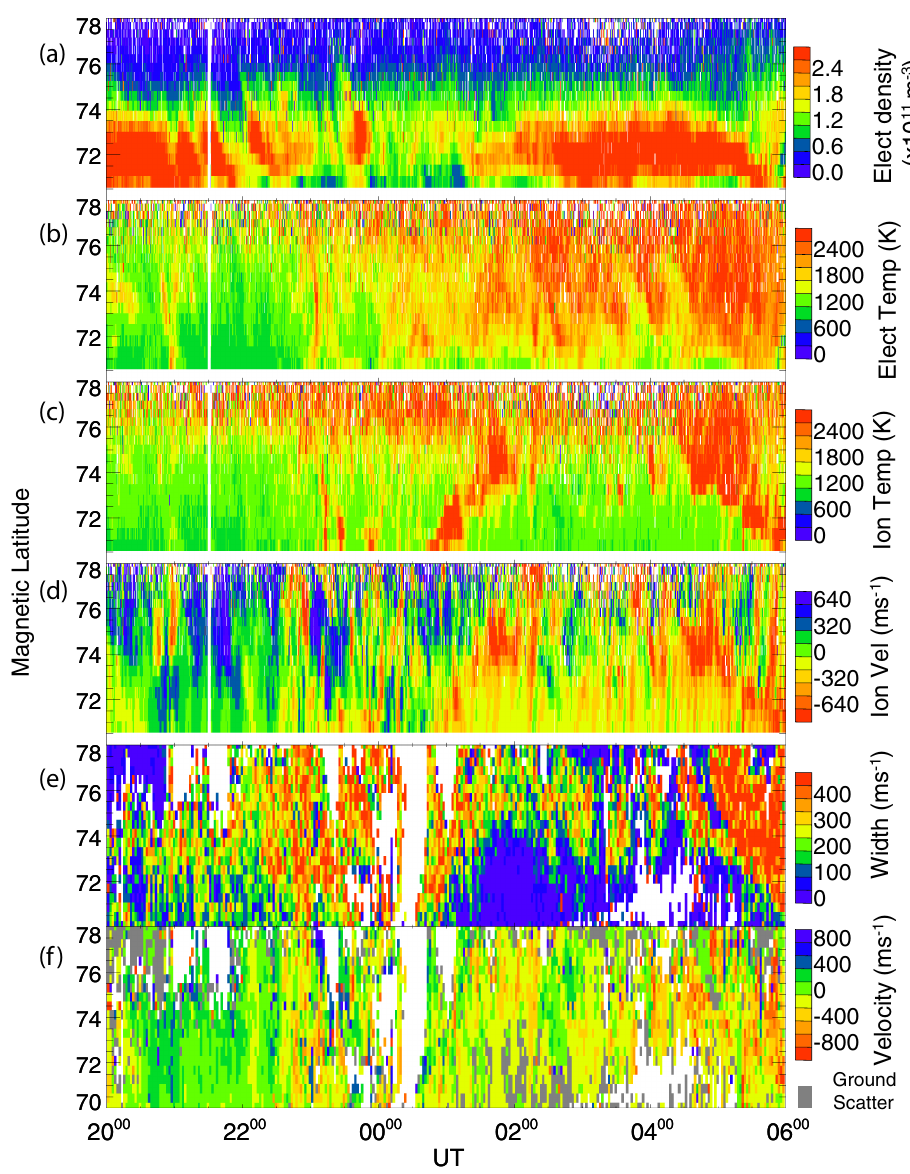
Fig. 6. Data from 22 to 23 November 1999. Panels (a) to (d) incoherent scatter data from EISCAT beam 2, 359 ◦ , electron density, electron temperature, ion temperature and ion line-of-sight velocity (negative values are away from the radar), respectively. Panel (e) spectral width from beam 9 of CUTLASS Finland, and panel (f) line-of-sight velocity (negative values are away from the radar) from the